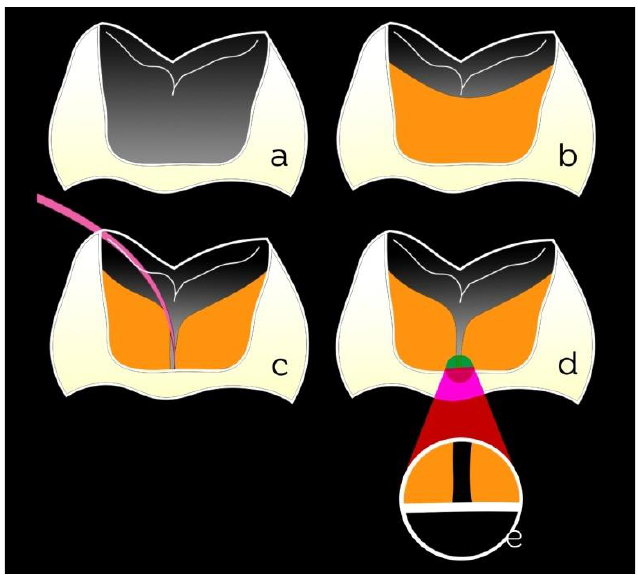
Figure 5. Restorative technique using single increment for dentin reconstruction. The cavity ( a ) is filled by single increment insertion of the dentin composite without photoactivation ( b ). The occlusion map is started using a very fine instrument ( c ). The instrument’s tip touches the bottom of the cavity, which allows the increments to be separated ( d , e ) and speeds up dentin construction.